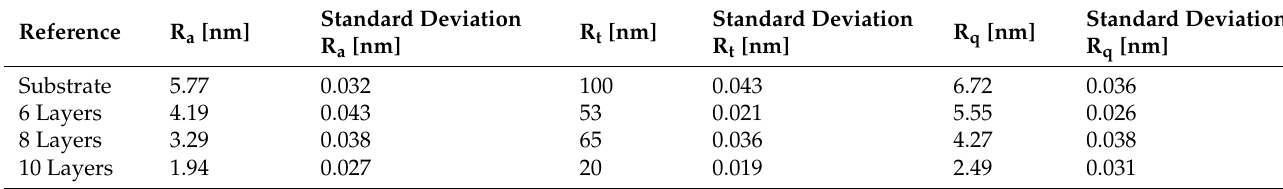
Table 4. Roughness characterization of the